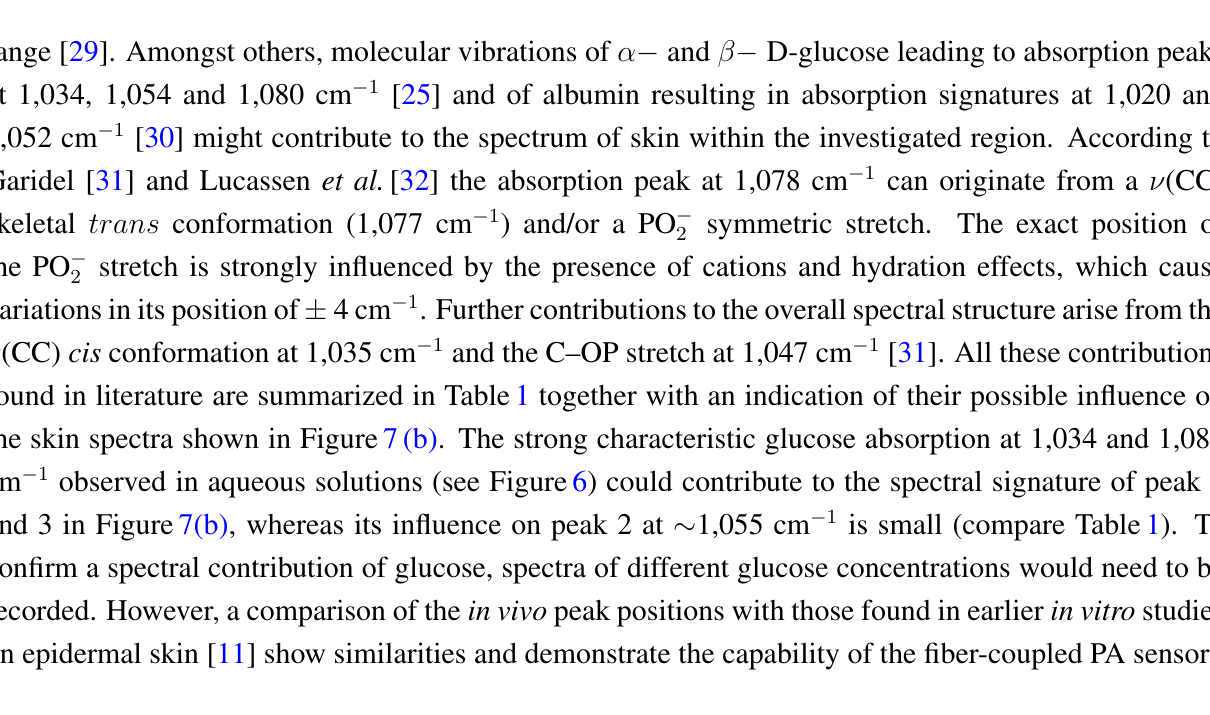
( a ) Picture of the fiber-coupled PA sensor attached with hook-and-loop stripes to the forearm; ( b ) PA spectrum of human skin measured at the finger tip and the forearm.